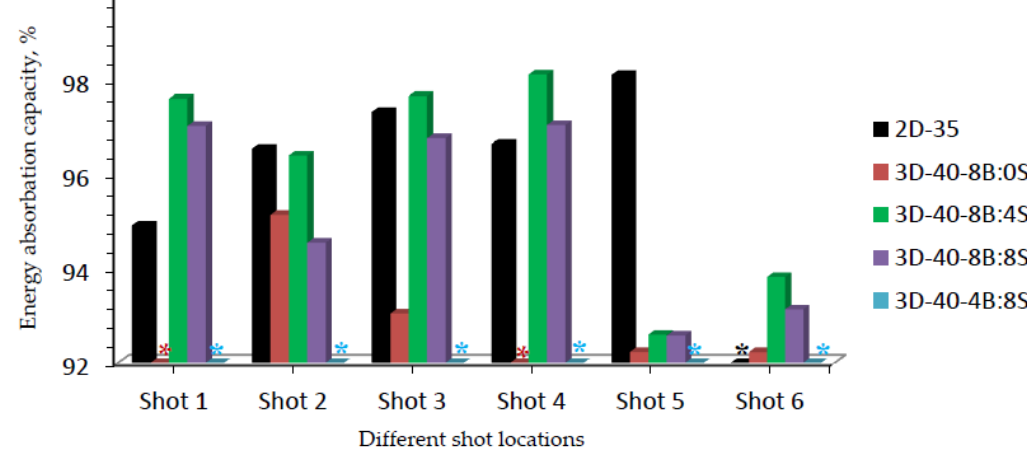
Figure 13. Energy-absorbing capability (%) for 3D and 2D fabric samples at different shot locations. ( * All shots penetrated sample 3D-40-4B:8S, * shot six penetrated sample 2D-35 and * shot 1 & 4 penetrated sample 3D-40-8B:0S).